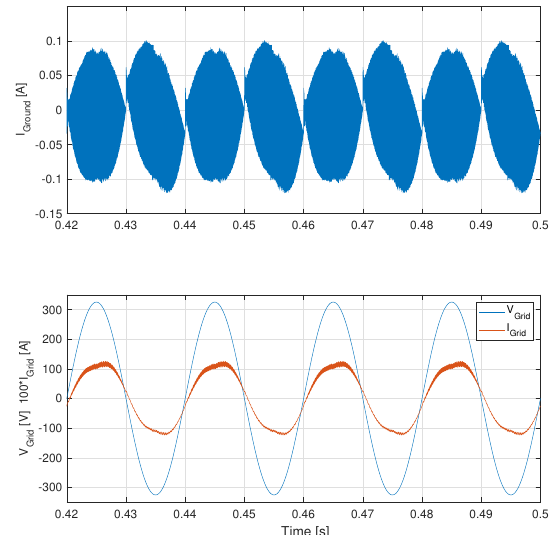
Figure 13. Ground leakage current waveform ( top ), injected grid current waveform ( × 100), and grid voltage waveform ( bottom ) in the case of CSI5 topology. The RMS of the ground leakage current results equal to 54 mA RMS